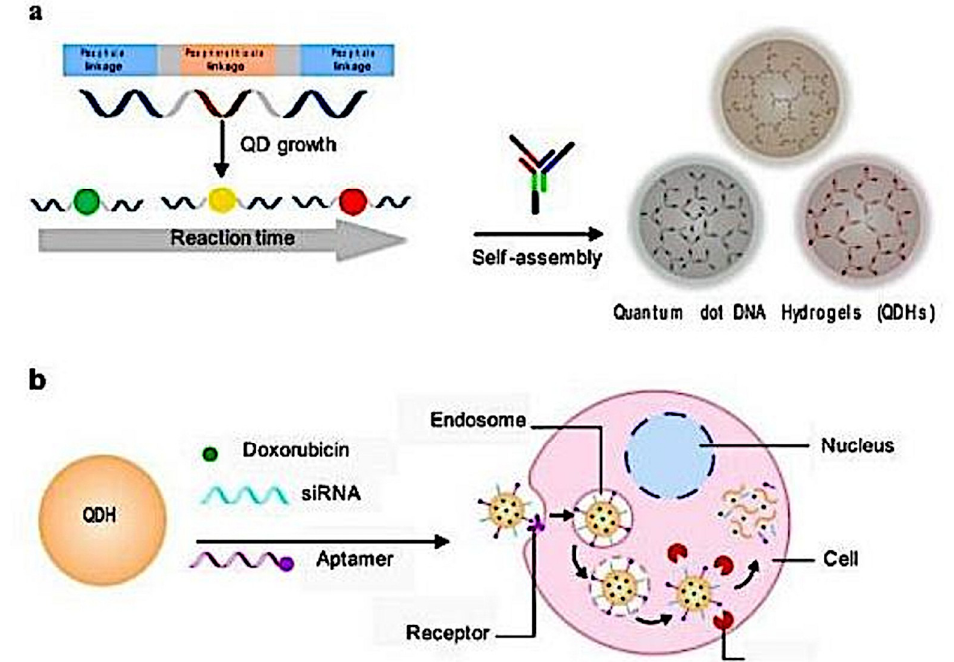
Figure 3. ( a ). Schematic view of the synthesis process of the DNA functionalized QDs followed by the formation of the QD hydrogel through hybridization with DNA. ( b ). Schematic view of the modification process on the QD hydrogel for specific targeting of the cell using aptamer for drug delivery. Release of Doxorubicin and siRNA happens after uptake into the cell via endocytosis (reprinted (adapted) with permission from [9]; the article is open access and the content reusable. Creative Commons